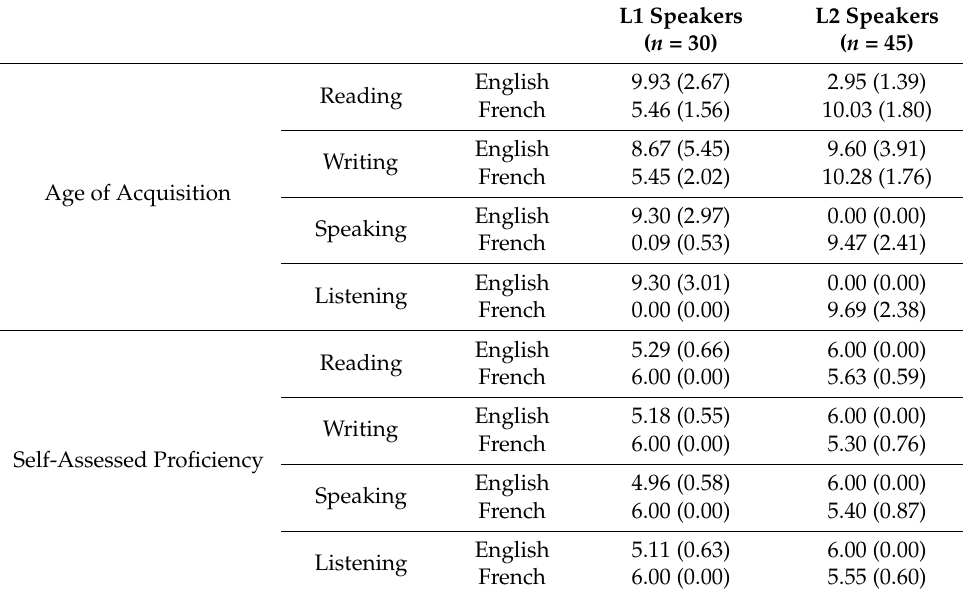
Table A1. Participants’ age of acquisition and self-assessed proficiency scores.